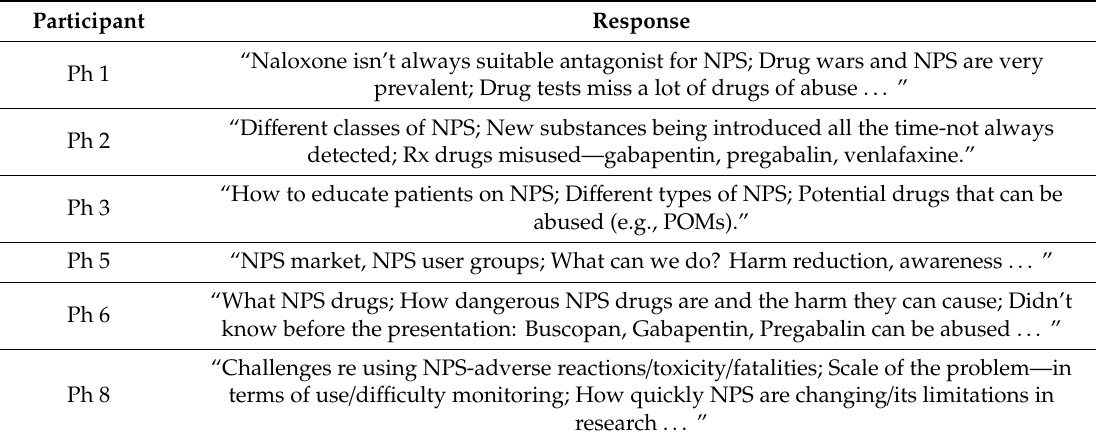
Table 5. Free text responses regarding learning from the CPD Pharmacy Event.